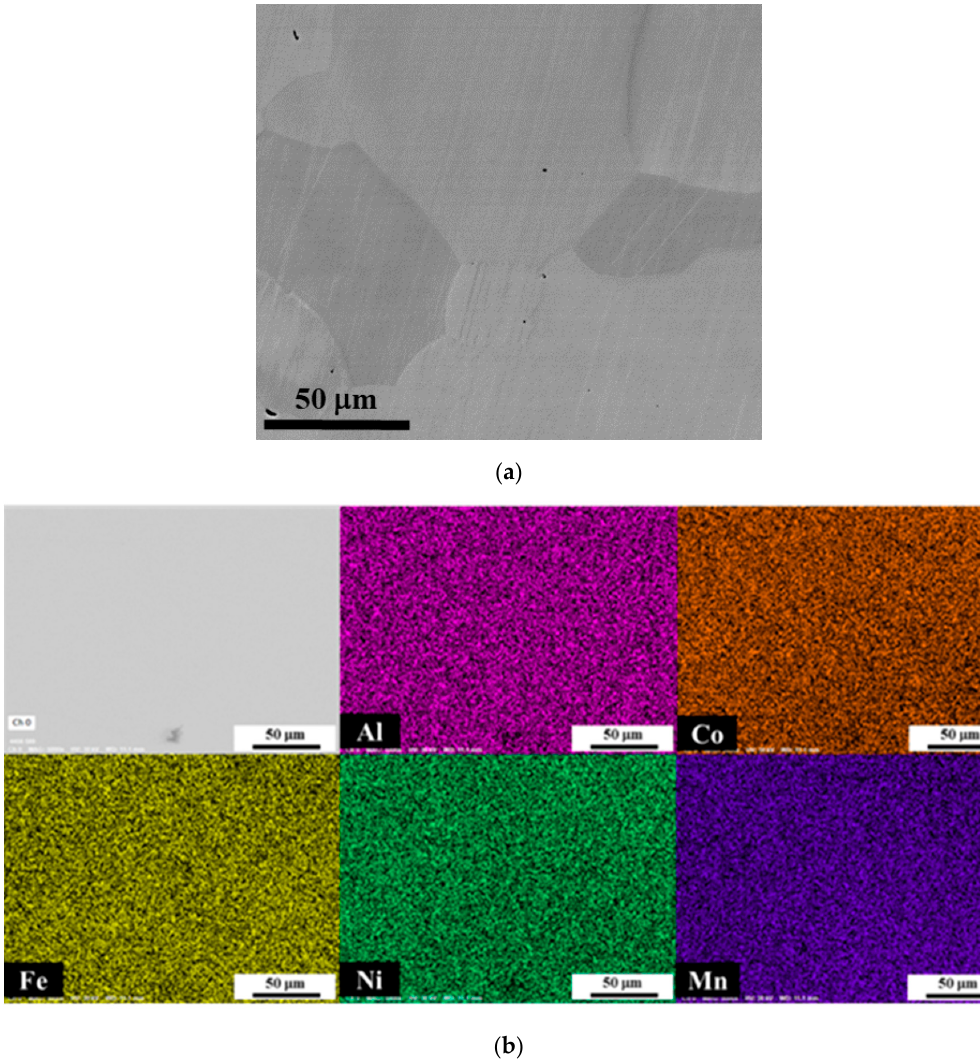
Figure 16. ( a ) SEM-BSE image. ( b ) Corresponding elemental mapping of Al(CoFeMnNi) quinary alloy heat treated at 1073 K, for 200